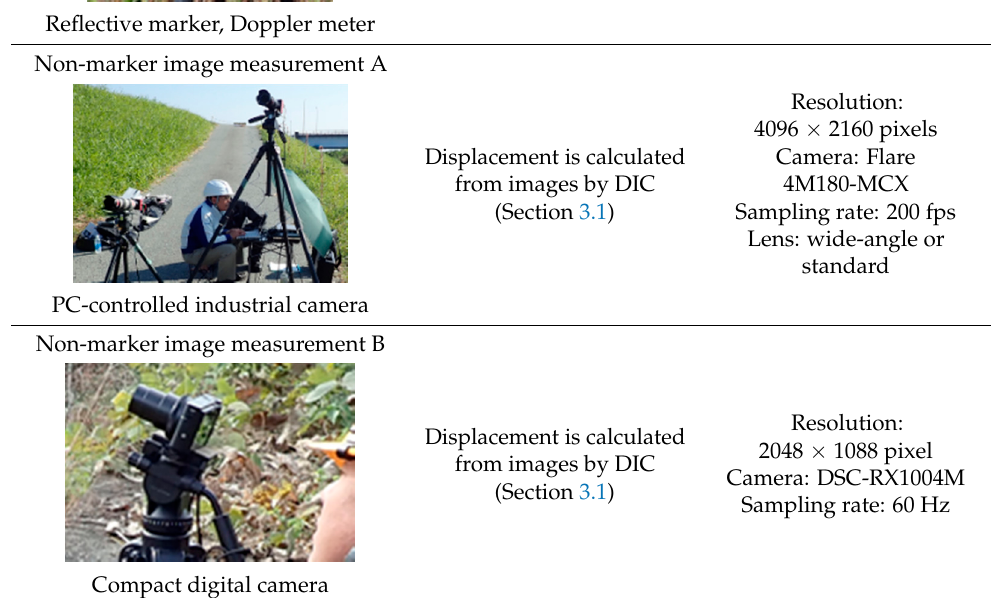
Figure 8. Installation status of each measuring device for bridge B.